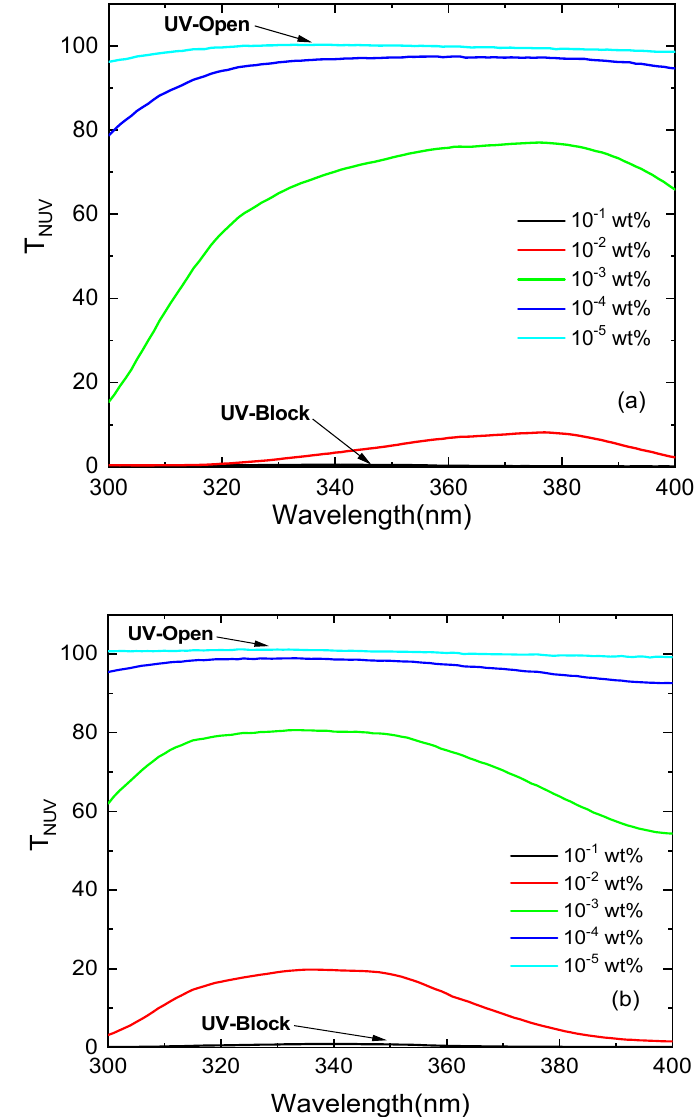
Figure 5. Transmission spectra in the NUV range for photoselective PMMA greenhouse films doped with perylene dyes ( a ) KREMER 94720 and ( b ) KREMER 94739.